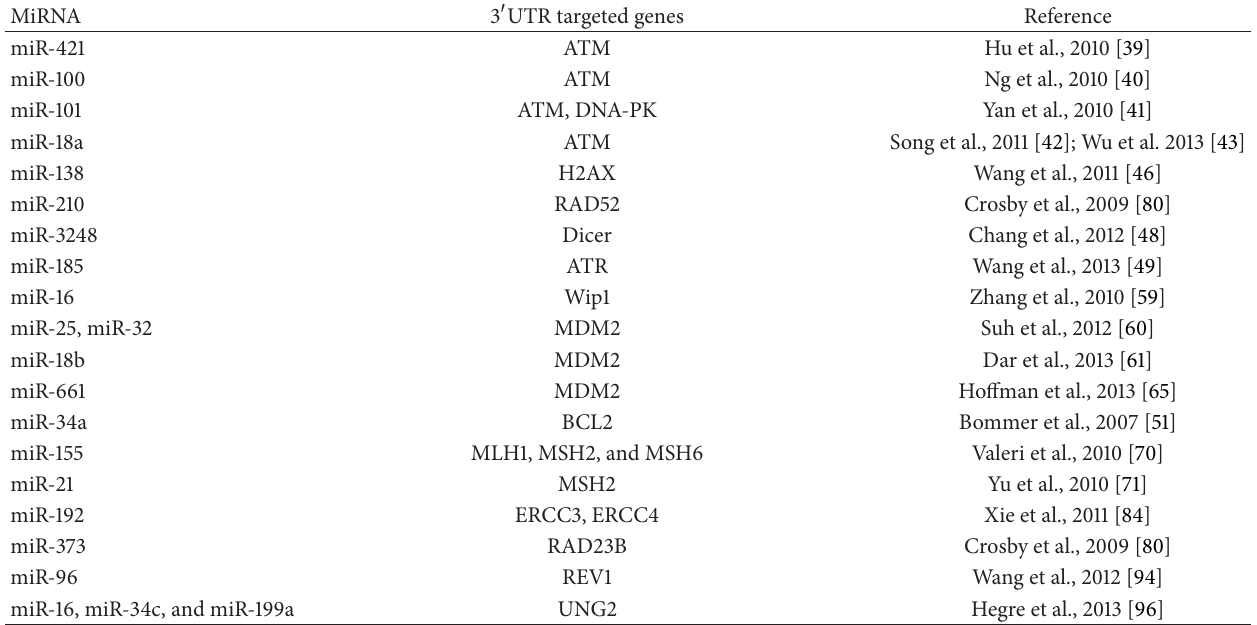
Table 1: MiRNAs involved in DNA damage/repair and 3 󸀠 -UTR targeted